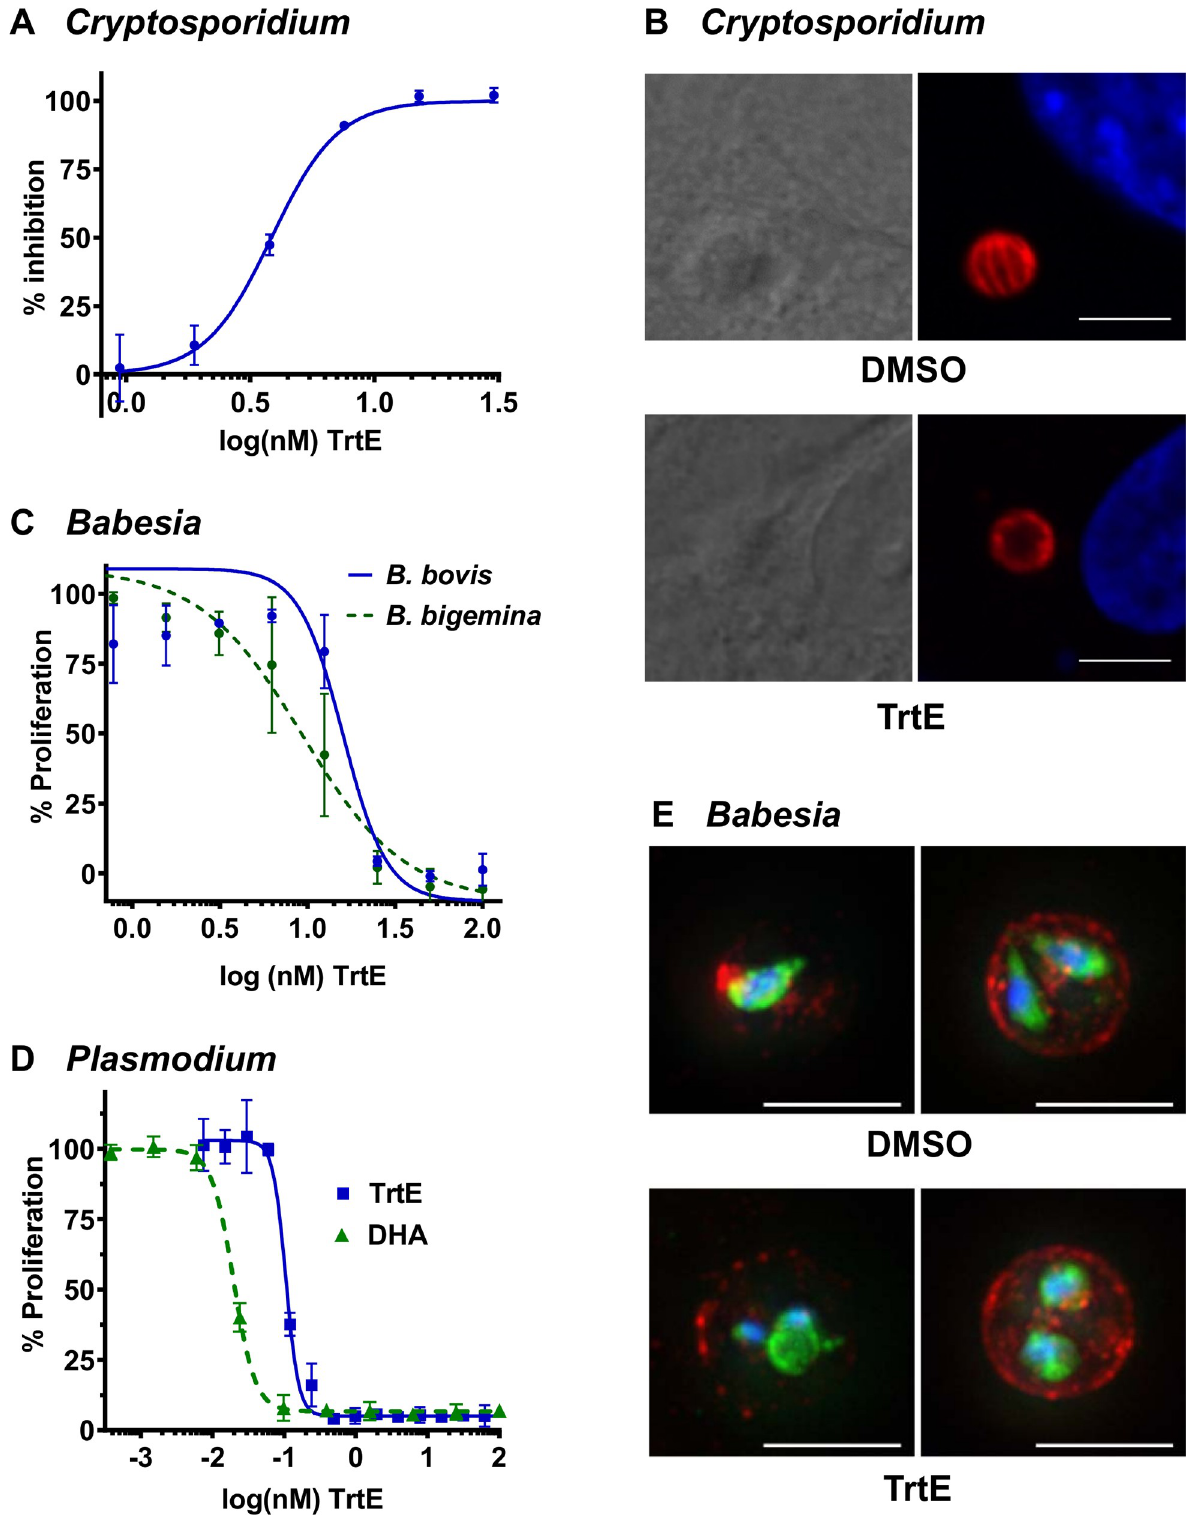
Fig 3. Tartrolon E is active against a broad spectrum of apicomplexan parasites in vitro : A. HCT-8 cells were infected with nanoluciferase expressing- Cryptosporidium parvum oocysts for 24 hours at which time dilutions of trtE were added to the infected cells. Parasite proliferation was